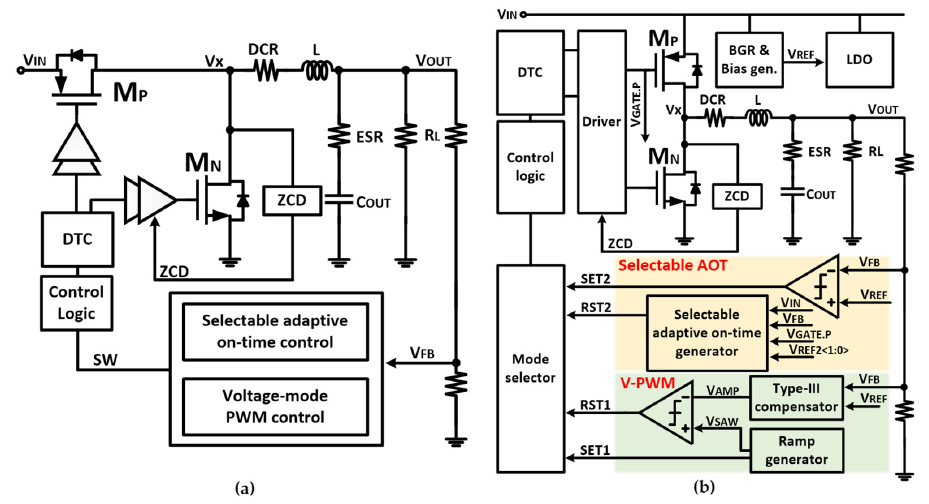
Figure 2. Proposed DC-DC buck converter with dual modes of PWM and selectable adaptive on-time controls: ( a ) simplified circuit diagram and ( b ) top block diagram.